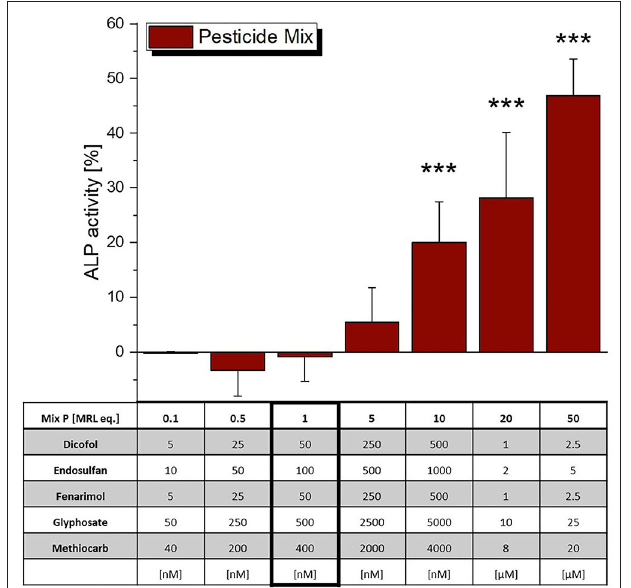
FIGURE 5 | Estrogenicity of a mixture of selected pesticides, as measured in ALP assays. Values were scaled to the solvent control (0%) and the positive control (1nM E2, 100%) and are expressed as means ± SD of at least 3 independent experiments. Significant differences to the solvent control were calculated by an one-way ANOVA test for each compound, followed by Fisher LSD post-hoc testing, and are indicated by “***” ( p < 0.001).